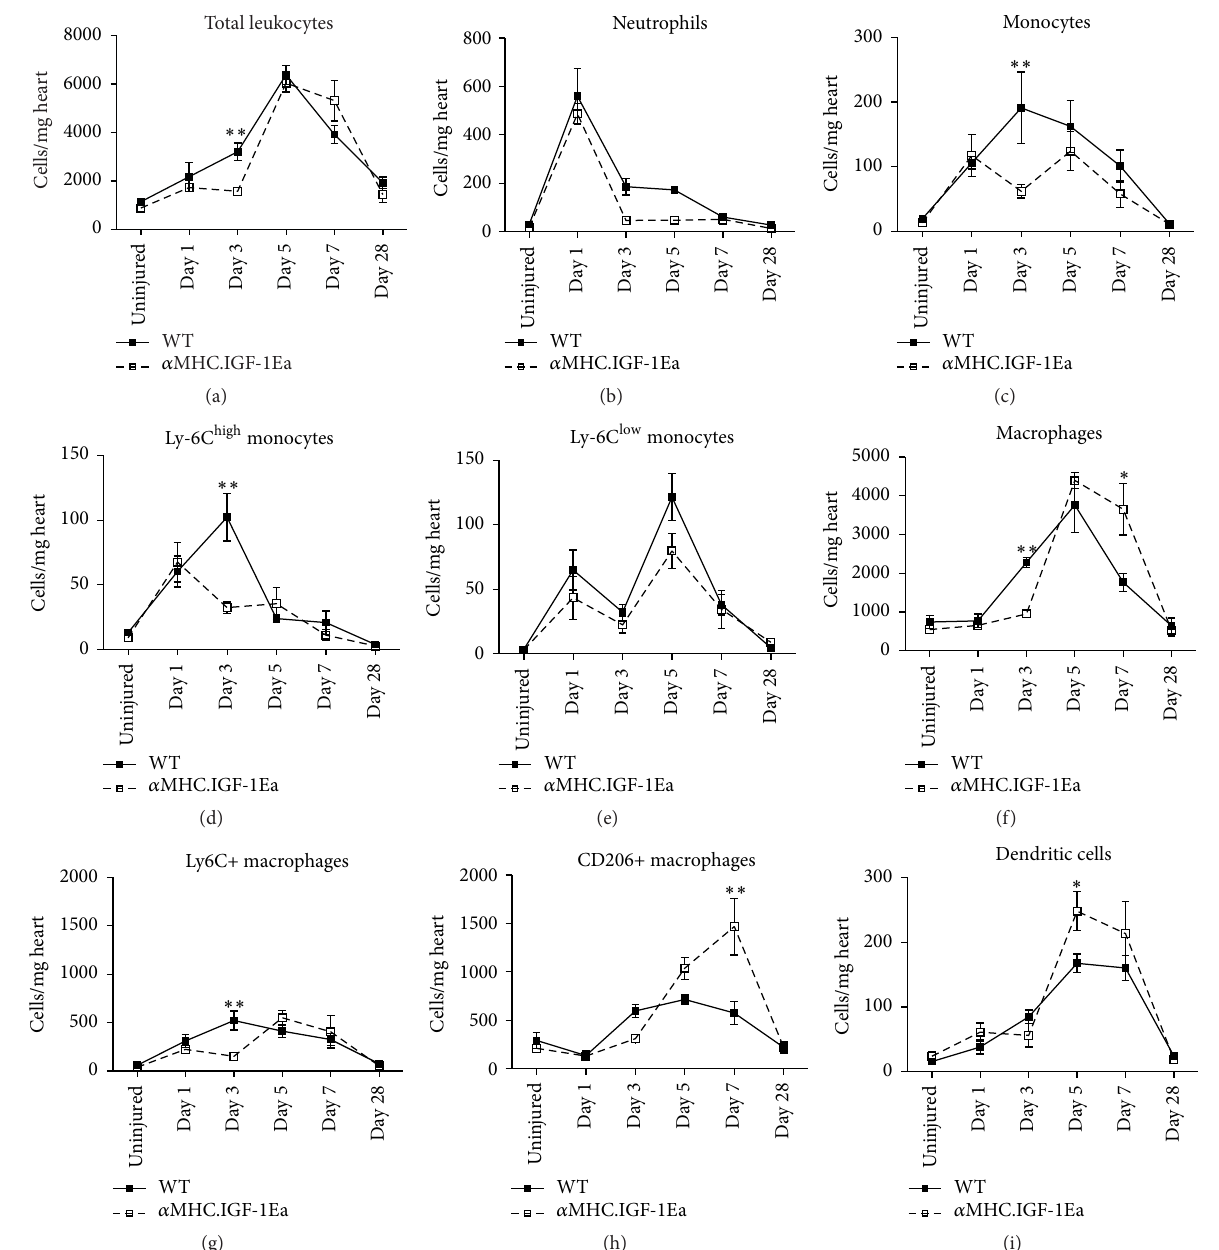
Figure 4: Characterisation and temporal dynamics of immune cell populations in 𝛼 MHC.IGF-1Ea hearts after MI. Quantification of (a) total leukocytes (CD45+), (b) neutrophils (CD45+, CD11b+, F4/80 − , CD11c − , and Ly6G+), and (c) monocytes (CD45+, CD11b+, CD11c − , Ly6G − , and F4/80 − ) which were further classified as (d) Ly 6 C high and (e) Ly 6 C low monocytes. (f) Macrophages (CD45+, CD11b+, CD11c − , Ly6G − , and F4/80+) were further characterised on the basis of Ly6C and CD206 expression as (g) Ly 6 C high /CD 206 low (inflammatory macrophages) and (h) Ly 6 C low /CD 206 high (reparative macrophages). For this work, only cells that were either Ly 6 C high /CD206 − or Ly6C − /CD206+ were analysed, although we noted a double positive cell population (i.e., CD206+, Ly6C+). (i) Dendritic cells were defined as CD45+, CD11b+, F4/80 − , CD11c+, and Ly6G − . Data is presented as the total number of cells per mg of heart. 𝑛 = 4 –6 per group. Two-tailed Student’s t -test was performed to compare WT versus 𝛼 MHC.IGF-1Ea at selected time points after MI. ∗ 𝑃 < 0.05 , ∗∗ 𝑃 < 0.005